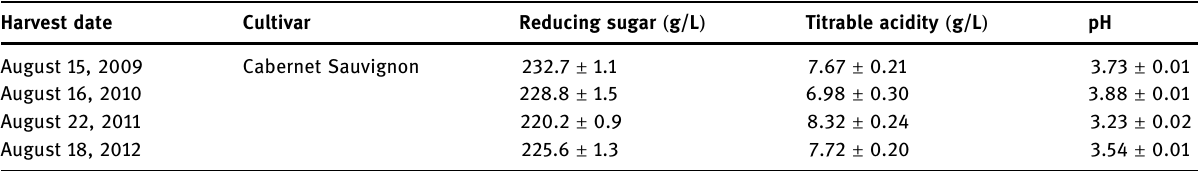
Table 2: Grape composition at harvest Harvest date